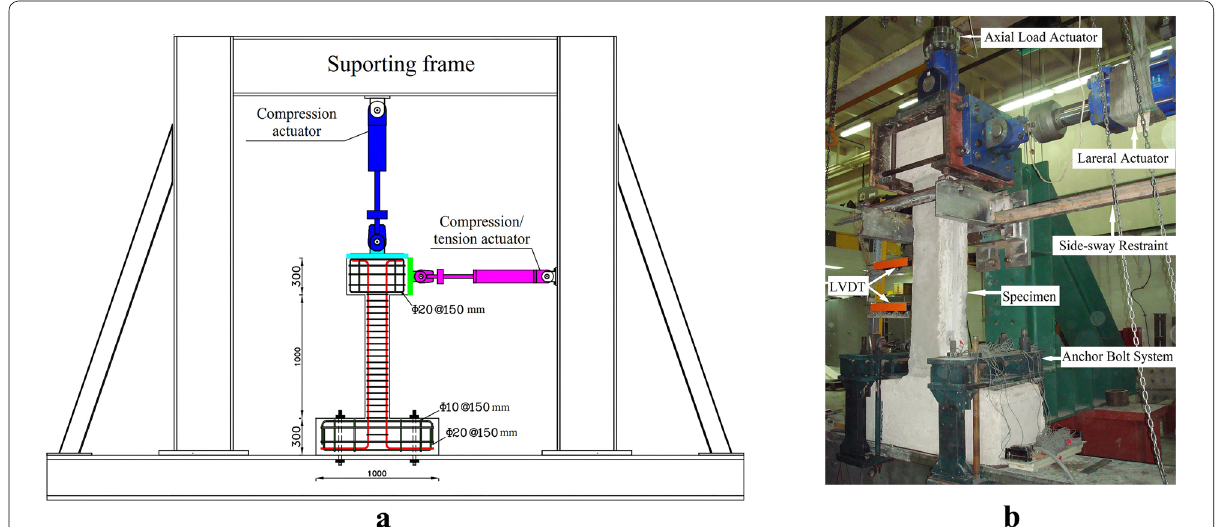
Fig. 2 Test setup: a schematic; b photograph (unit;